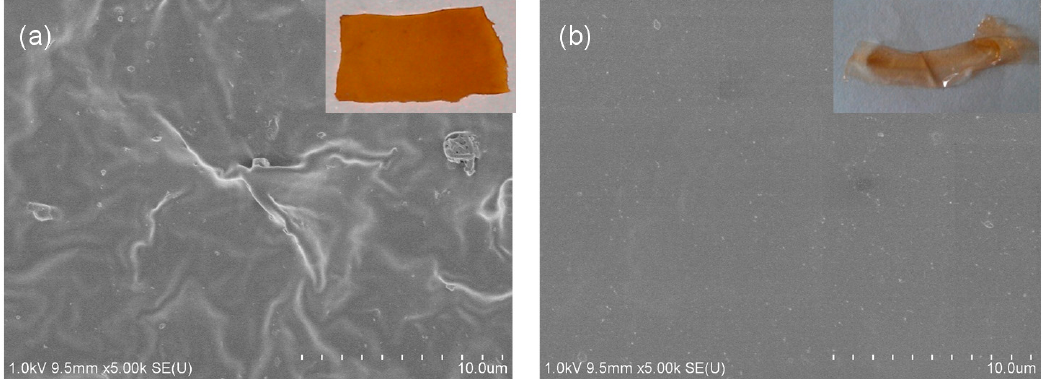
Figure 5. SEM and photo images of the PDOPA- g -PLA 20 copolymer films before ( a ) and after ( b ) degradation.